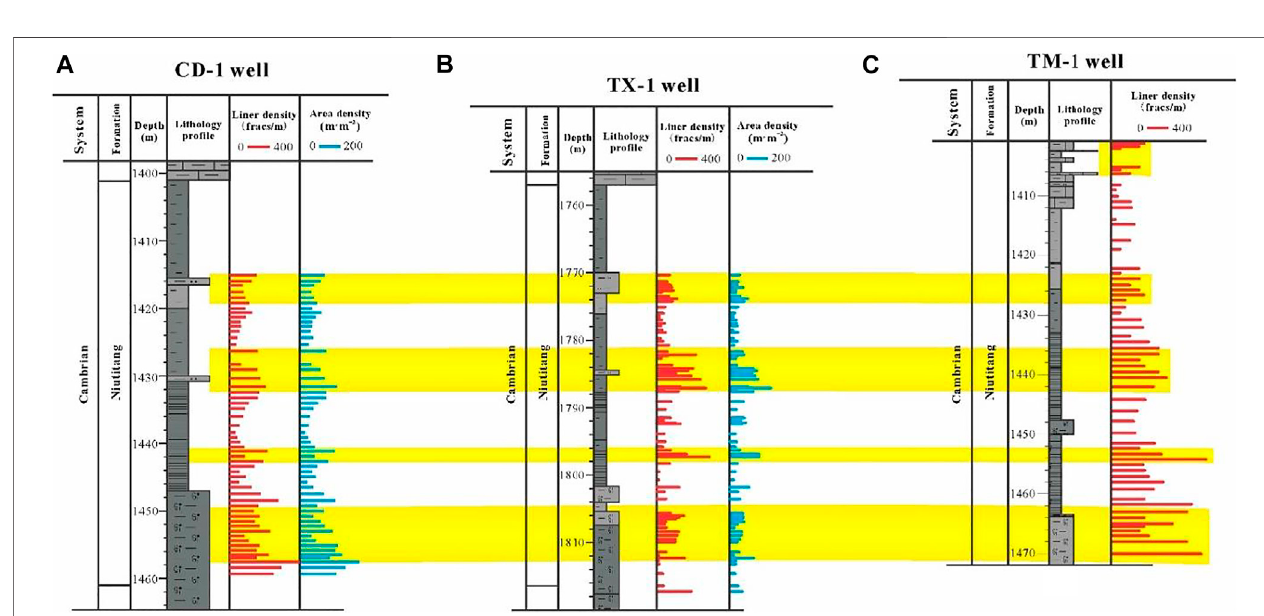
FIGURE 10 | CD-1, TX-1 and TM-1 well pro fi les of fracture density in Niutitang shale.